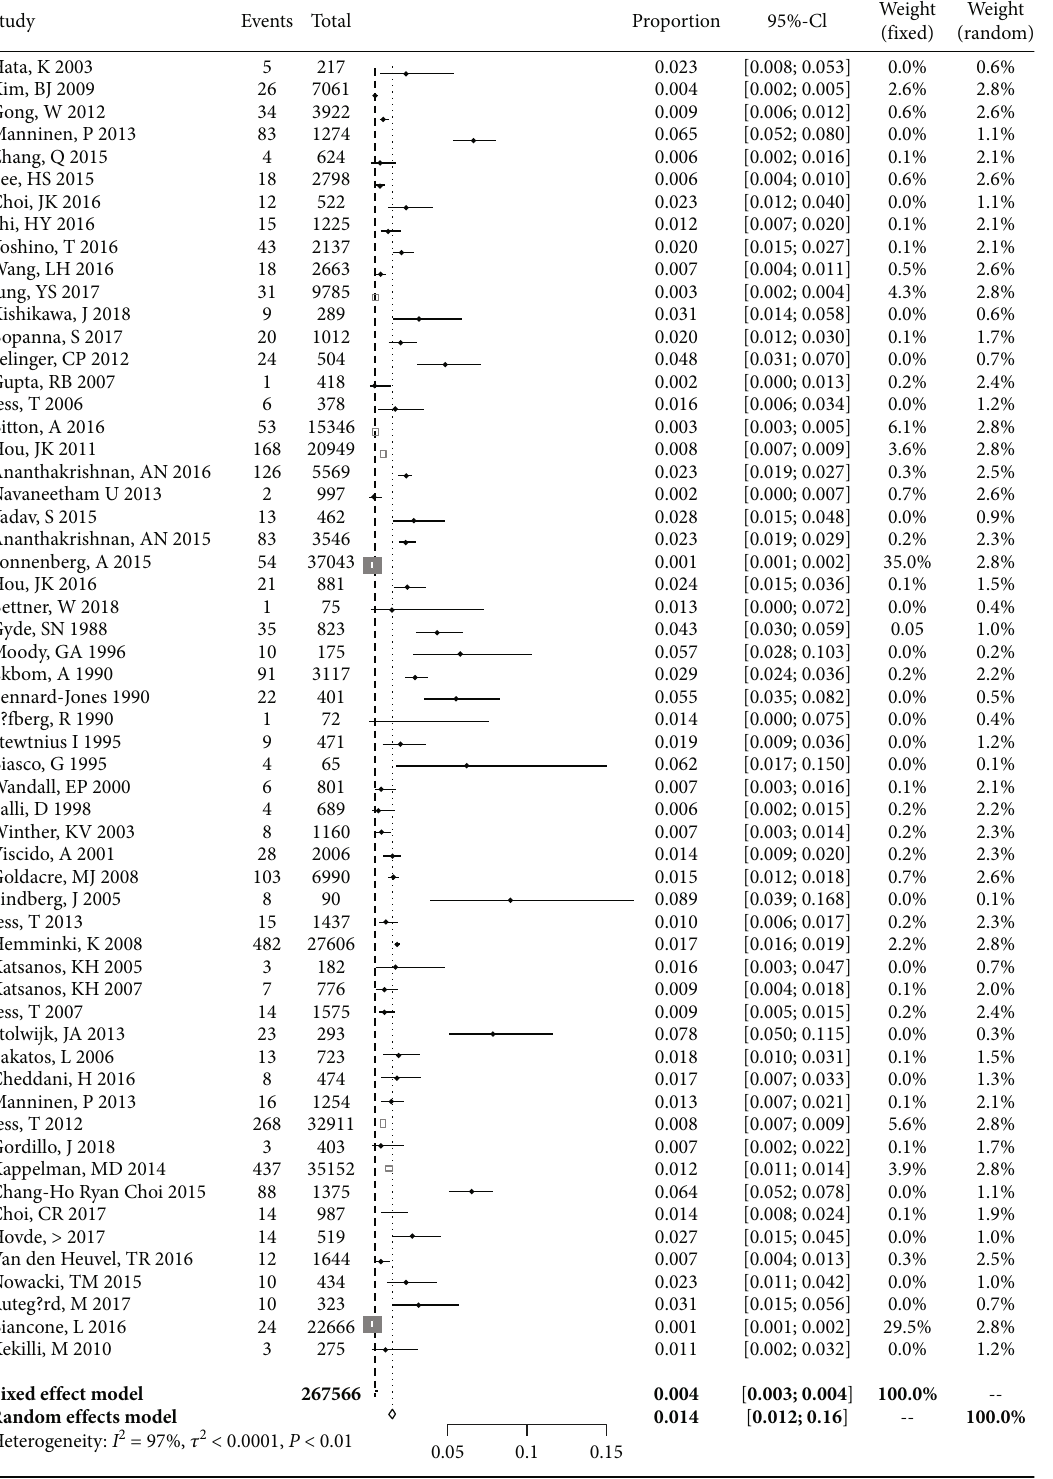
Figure 2: Individual and SIRs of CRC risk in UC: a meta-analysis of population-based cohort